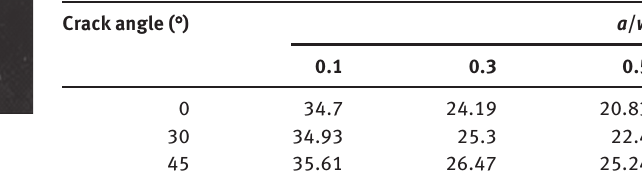
Table 3 Energy absorption of the unpatched cracked